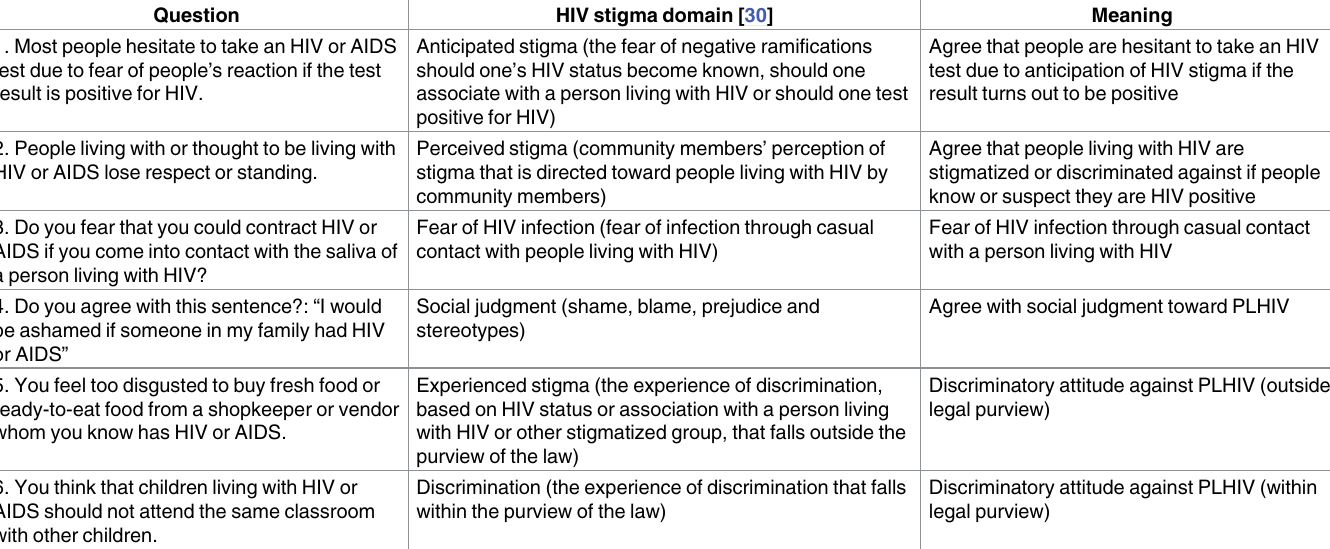
Table 1. Questions asked and their corresponded HIV stigma domain and